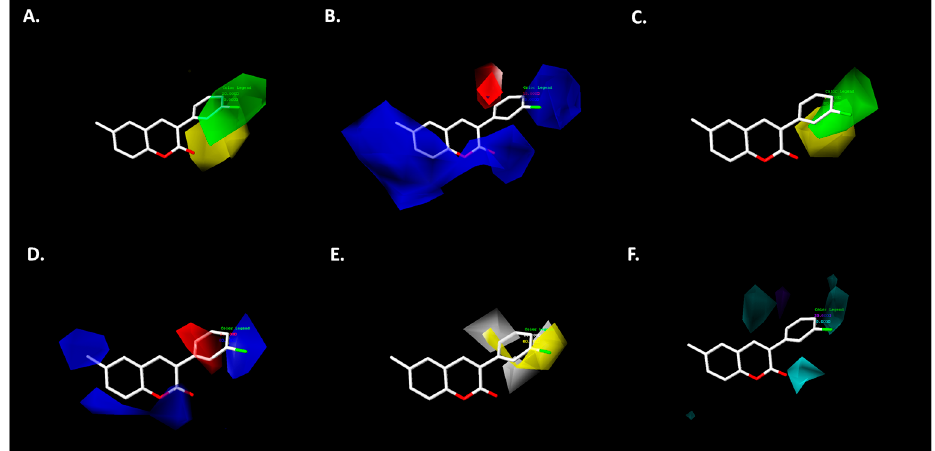
Figure 3. Contour map of 3D-QSAR results for MAO-B inhibitors around 3-(3 ′ -bromophenyl)-6- methylcoumarin ( 65 ). ( A ) CoMFA steric map. ( B ) CoMFA electrostatic map. ( C) CoMSIA steric map. ( D ) CoMSIA electrostatic map. ( E ) CoMSIA hydrophobic map. ( F ) Hydrogen-bond donor map. Color code: steric contour map green—bulky groups are favorable for the activity; steric contour map yellow—small groups are favorable for the activity; electrostatic contour map red—negative charge is favorable for the activity; electrostatic contour map blue—positive charge is favorable for the activity; hydrophobic contour map yellow—hydrophobic groups are favorable for the activity; hydrophobic contour map grey—hydrophilic groups are favorable for the activity; hydrogen-bond donor map cyan—hydrogen-bond donor groups are favorable for the activity; hydrogen-bond donor map purple—hydrogen-bond donor groups are unfavorable.